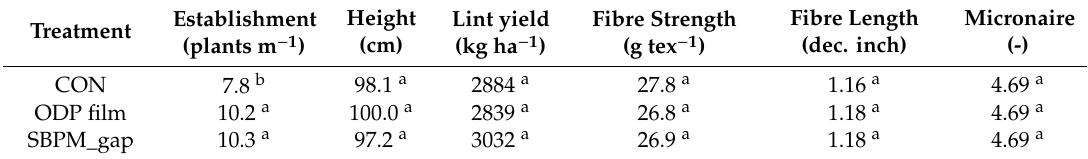
Table 2. The comparison of final cotton establishment in 2015 / 16 (51 DAS), plant height (122 DAS), lint yield and fibre quality 1 parameters of cotton grown on plots treated with sprayable biodegradable polymer membrane (SBPM), oxo-degradable plastic (ODP) mulch film, and a control plot with no mulch (CON) at the ACRI field site ( n = 9